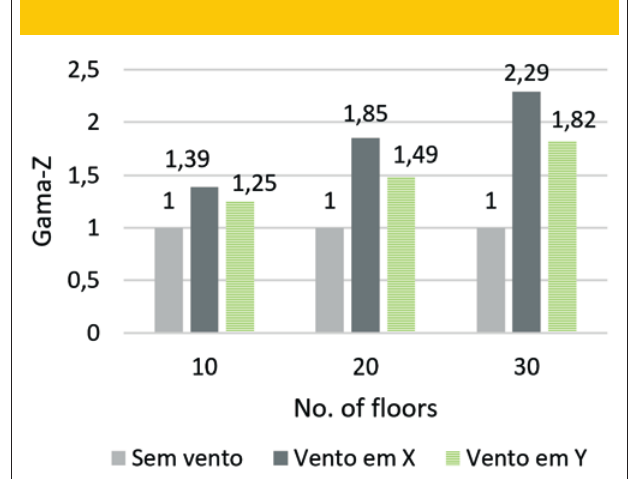
Figure 7 – Variation of gamma z